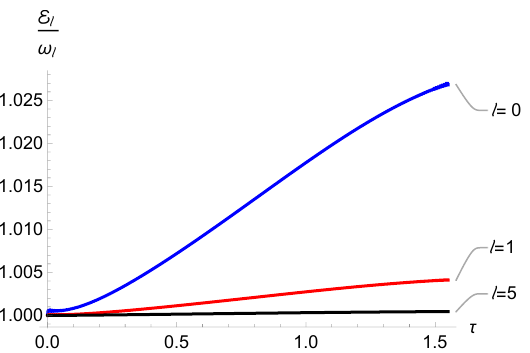
Figure 3 . The energy per harmonic E ‘ divided by the initial frequency ! ‘ , or the occupation number per mode as a function of (cid:28) for (cid:21) 0 = 40 (cid:25) and (cid:21) 0 (cid:27) 0 = 0 : 2. of the quantum (cid:13)uctuations into the mean (cid:12)eld and the value of the mass at late times is a function of the interaction strength (cid:21) and the initial VEV (cid:27) of the mean 0 0